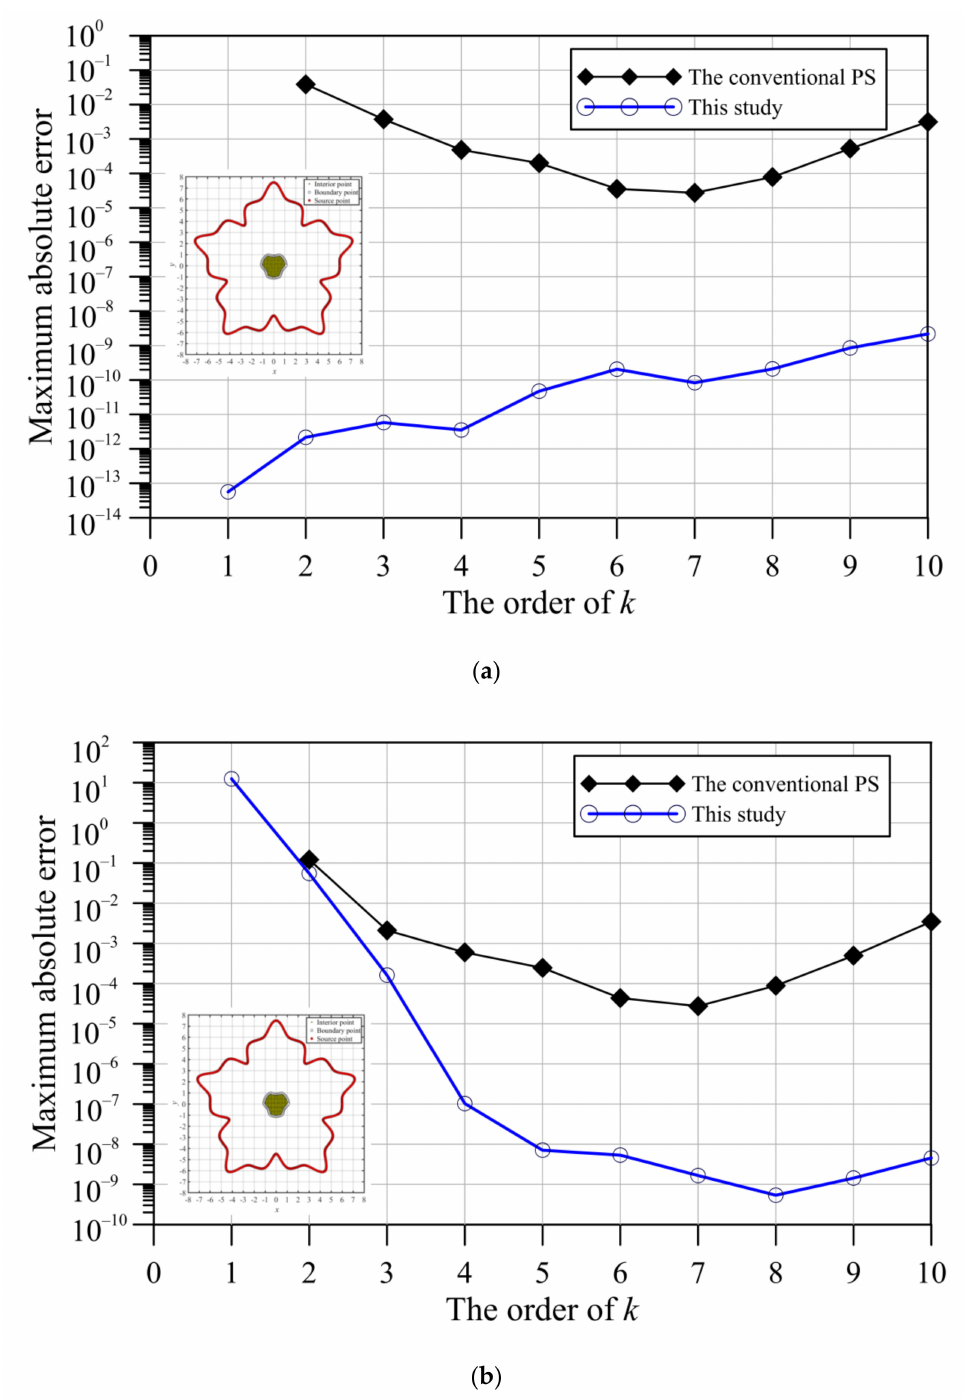
Figure 11. The computed MAE values of the original PRBF and the proposed method: ( a ) p = 0.0001; ( b ) p =